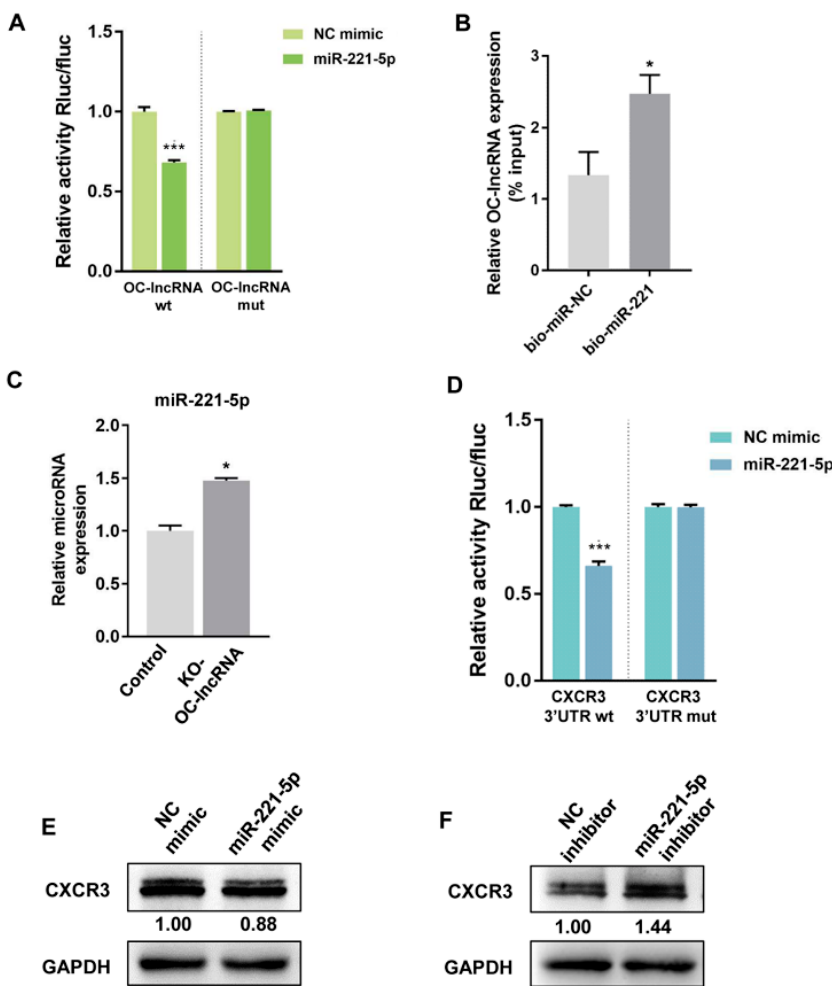
Figure 4. miR-221-5p bound to OC-lncRNA and CXCR3 mRNA. ( A ) Wt-OC-lncRNA or mut-OC- lncRNA were co-transfected with miR-221-5p mimics or NC mimics in HEK-293T cells. Luciferase report activity was detected. ( B ) OC-lncRNA was pulled down by biotin-labeled NC mimic (bio- miR-NC) or miR-221-5p (bio-miR-221) to determine the interaction between OC-lncRNA and miR-